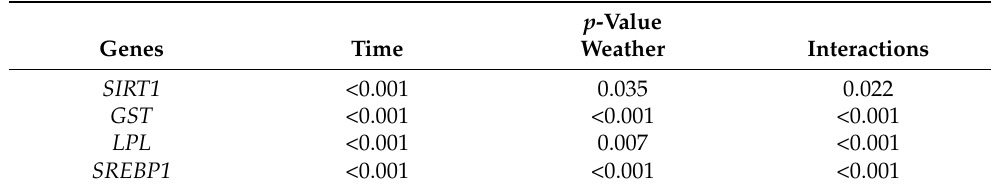
genes in mackerel tuna are shown in Table 6. The main effect of time and weather was significant ( p < 0.05); time and different weather had a significant interaction effect ( p < 0.05) on metabolic gene expression levels in mackerel tuna. Table 6. Effects of light intensity and duration on metabolic genes in mackerel tuna under different weather conditions. p -Value Genes Time Weather Interactions SIRT1 <0.001 0.035 0.022 <0.001 <0.001